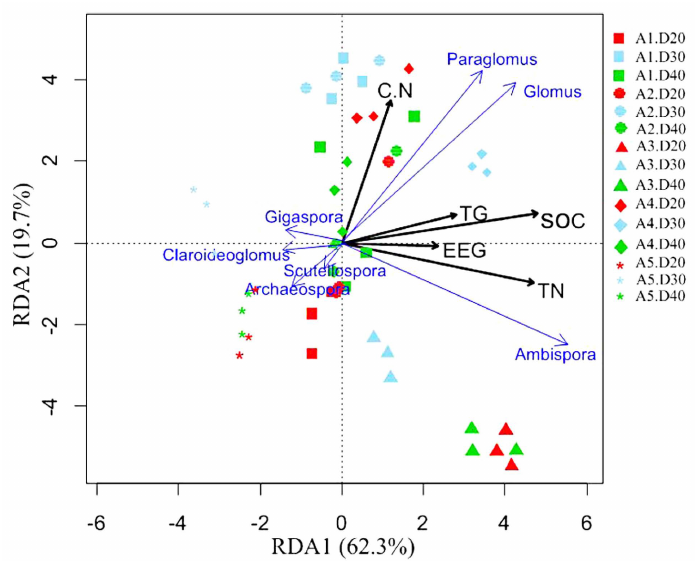
Figure 6. Comparison of the AMF communities in the soil via RDA. Note: A, aggregate size class (A1: >2 mm, A2: 1–2 mm, A3: 0.25–1 mm, A4: 0.053–0.25 mm, A5: <0.053 mm).